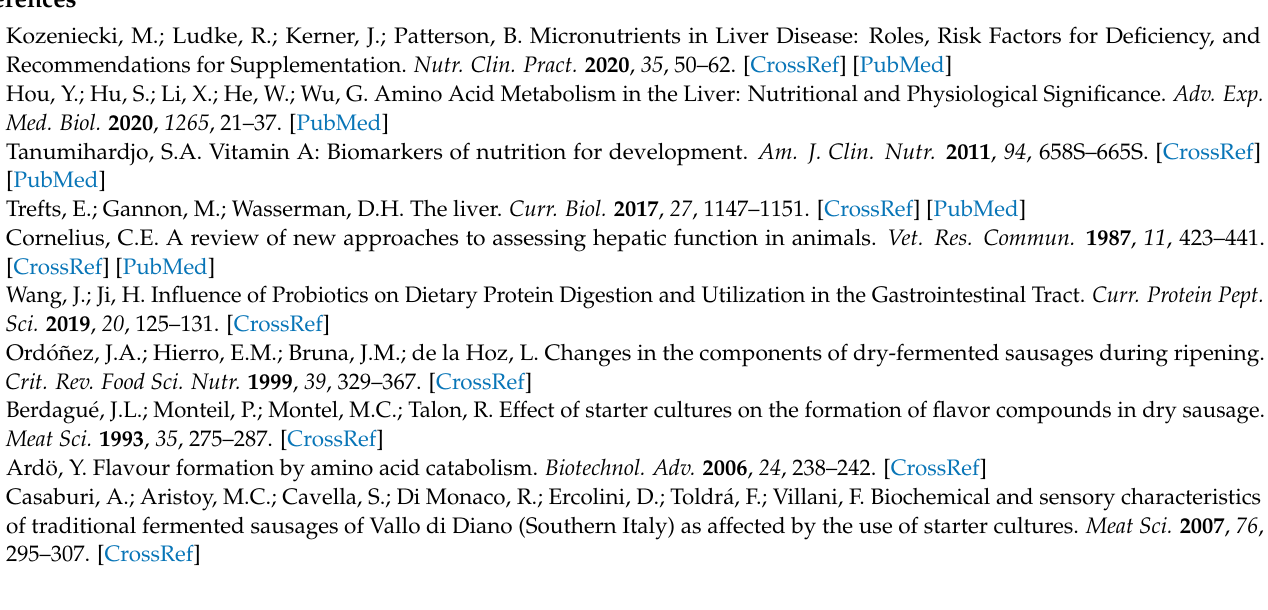
Table S3: Changes of pH value of lamb liver paste with three different treatments during storage period; Table S4: Changes of Aw value of lamb liver paste with three different treatments during storage period; Table S5: Changes of L* value of lamb liver paste with three different treatments during storage period; Table S6: Changes of a* value of lamb liver paste with three different treatments during storage period; Table S7: Changes of b* value of lamb liver paste with three different treatments during storage period; Table S8: Changes of TVB-N value in lamb liver paste with three different treatments during storage period; Table S9: Changes of TBARS value in lamb liver paste with three different treatments during storage period; Table S10: Changes of moisture content in lamb liver paste with three different treatments during storage period; Table S11: Changes of protein content in lamb liver paste with three different treatments during storage period; Table S12: Changes of fat content in lamb liver paste with three different treatments during storage